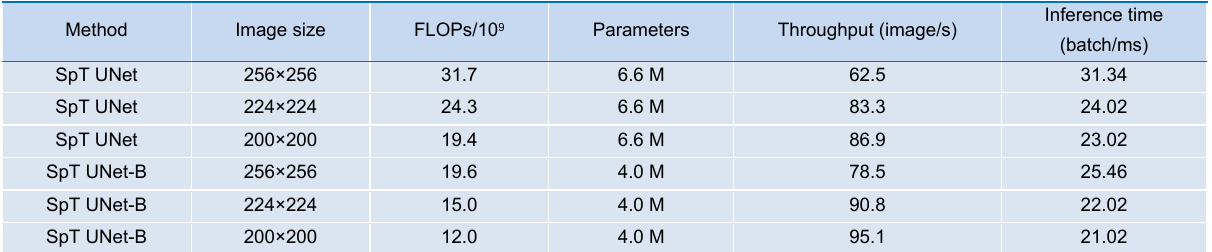
Table 2 | Performance of the SpT